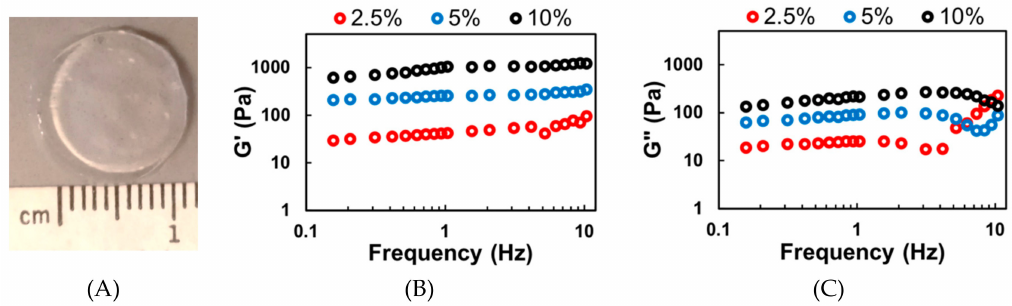
Figure 2. Rheological analysis of photopolymerized and crosslinked Me-HA (x-MeHA) hydrogels. ( A ) Photograph of a crosslinked x-MeHA hydrogel. Averaged ( B ) storage modulus (G’) and ( C ) loss modulus (G”) measurements from hydrogels fabricated using 2.5% (red), 5% (blue), or 10% (black) w / v MeHA. N ≥ 15 hydrogels per